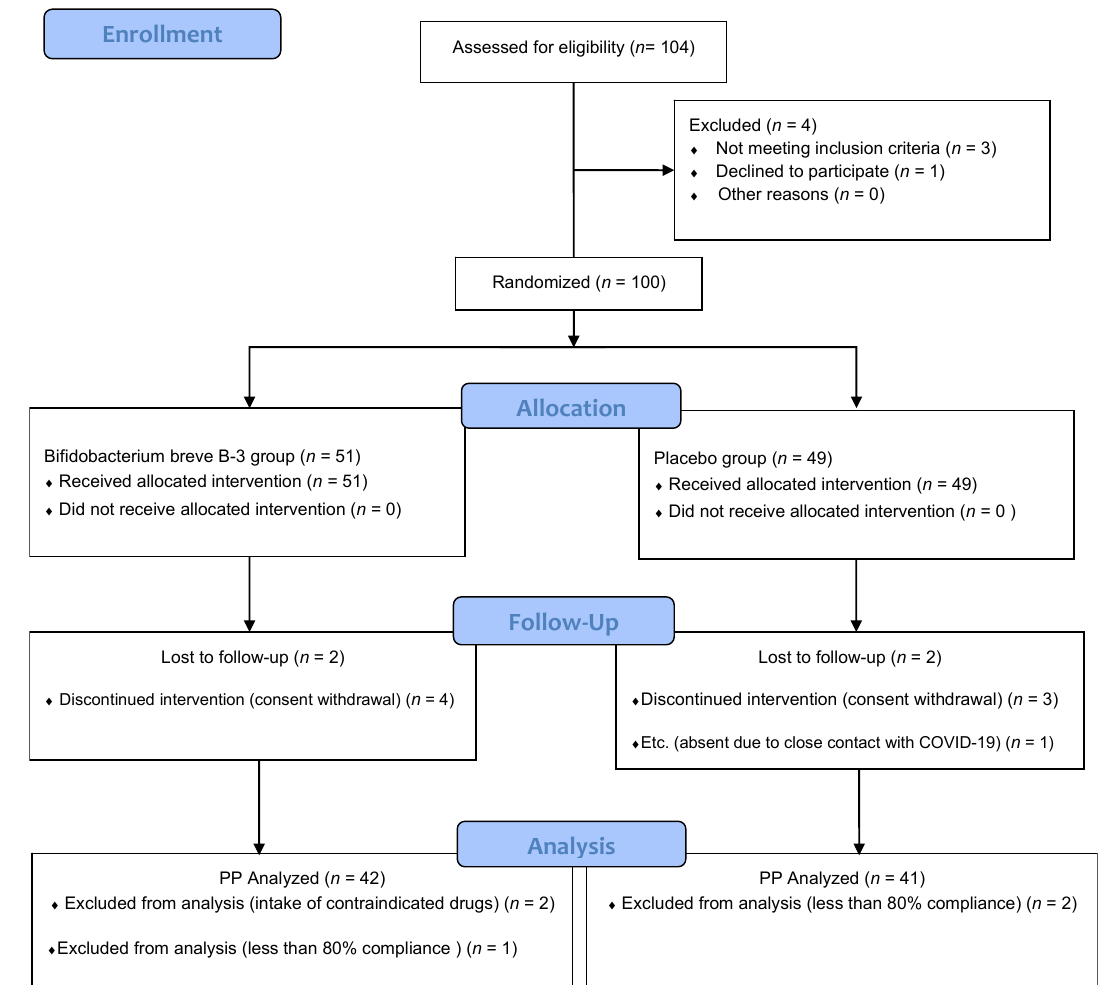
Assessed for eligibility ( n = 104)